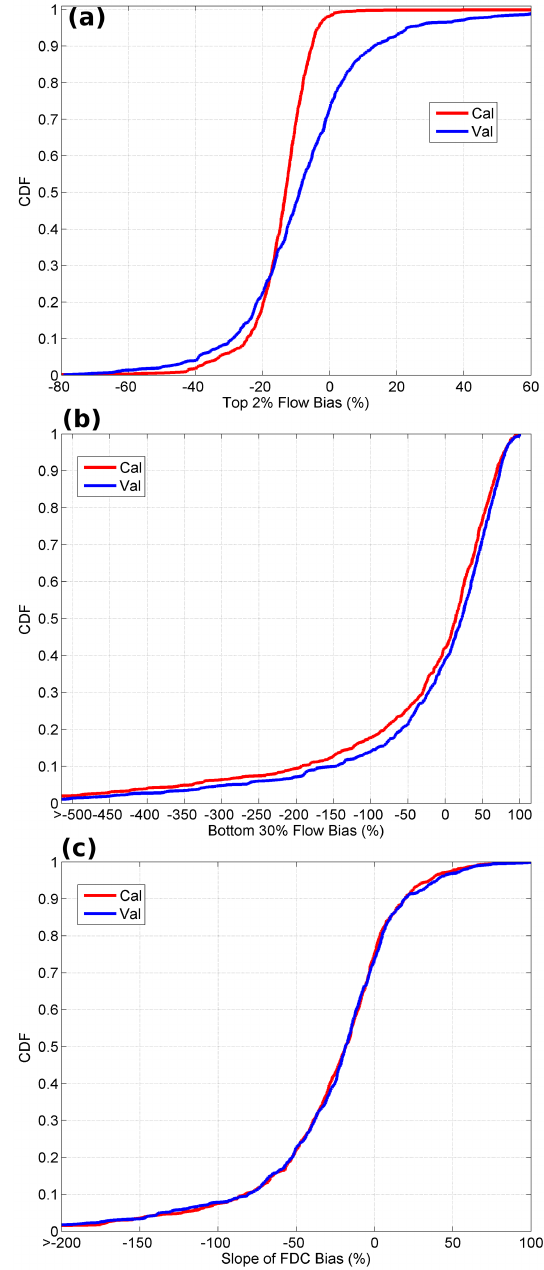
Figure 9. (a) CDFs for model high flow bias for the calibration (red) and validation periods (blue), (b) model low flow bias, and (c) model flow duration curve slope